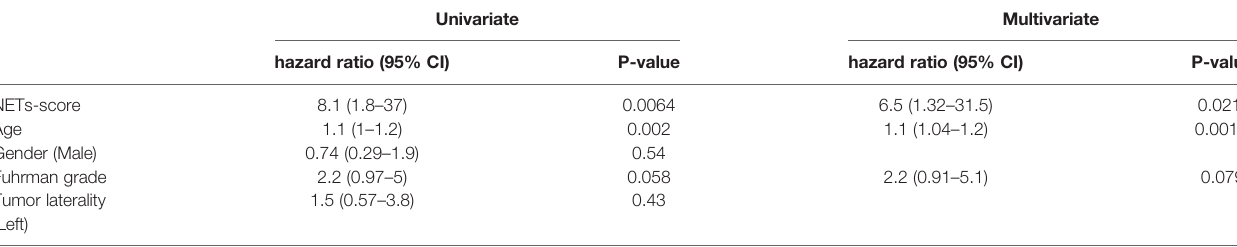
TABLE 2 | Univariate and multivariable Cox proportional hazard regression analysis in the TCGA